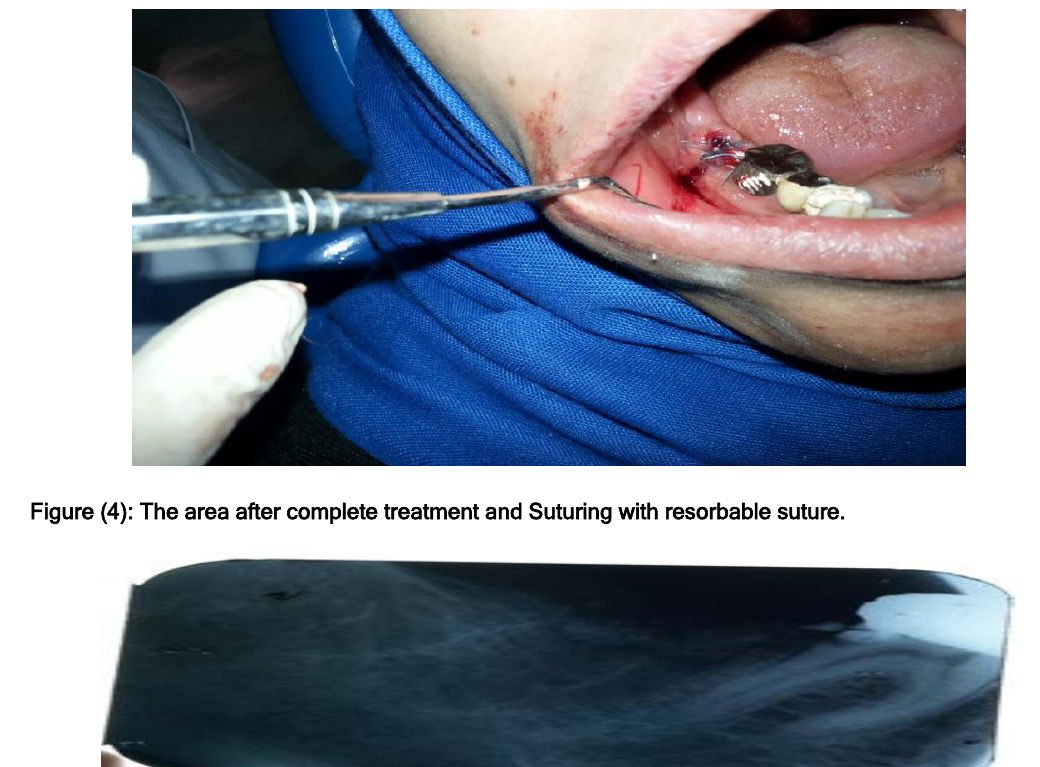
Figure (3): Show the composite bone graft material.